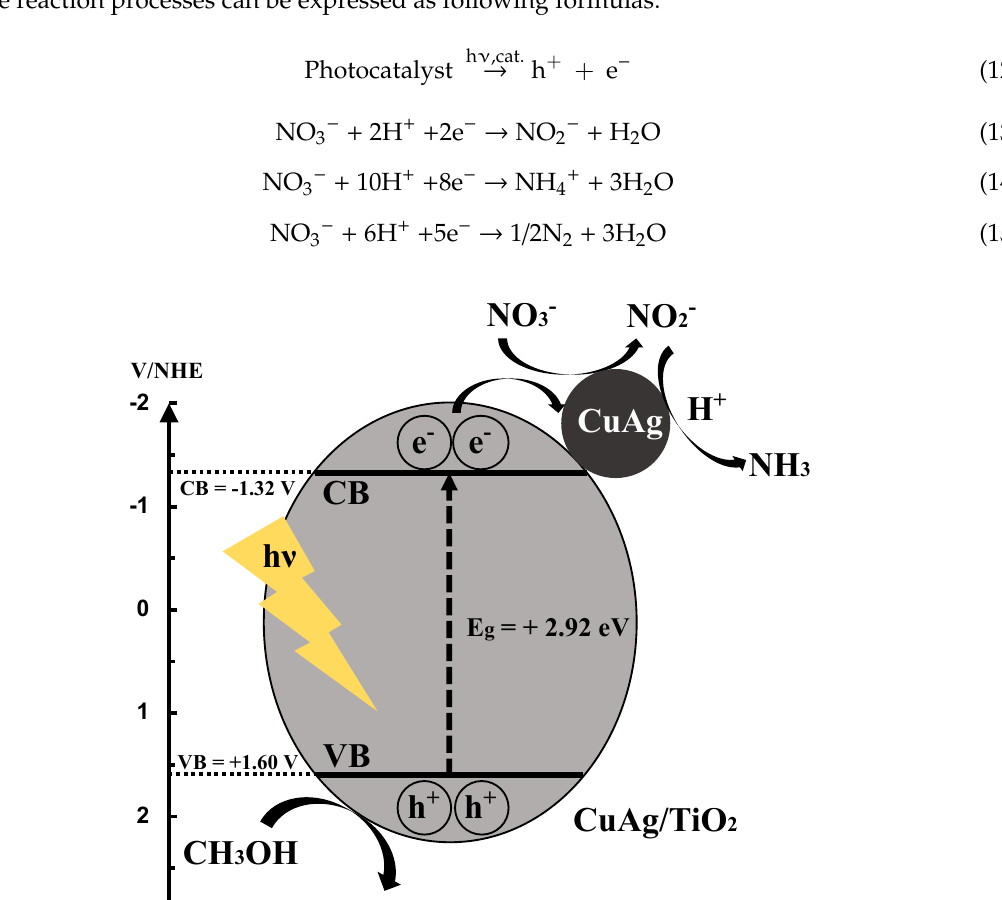
samples, Figure S5: Cu 2p core level spectra in TiO 2 samples, Figure S6: Ag 3d core level spectra in TiO 2 samples, and Figure S7: Oxidation of methanol to HCOOH during NO 3 − reduction under UV irradiation for 3 hours. Author Contributions: R.K. and S.K. conceived and designed the experiments. R.K. performed the experiments and wrote the paper. I.T., M.F. and H.K. analyzed the results and advised the project.